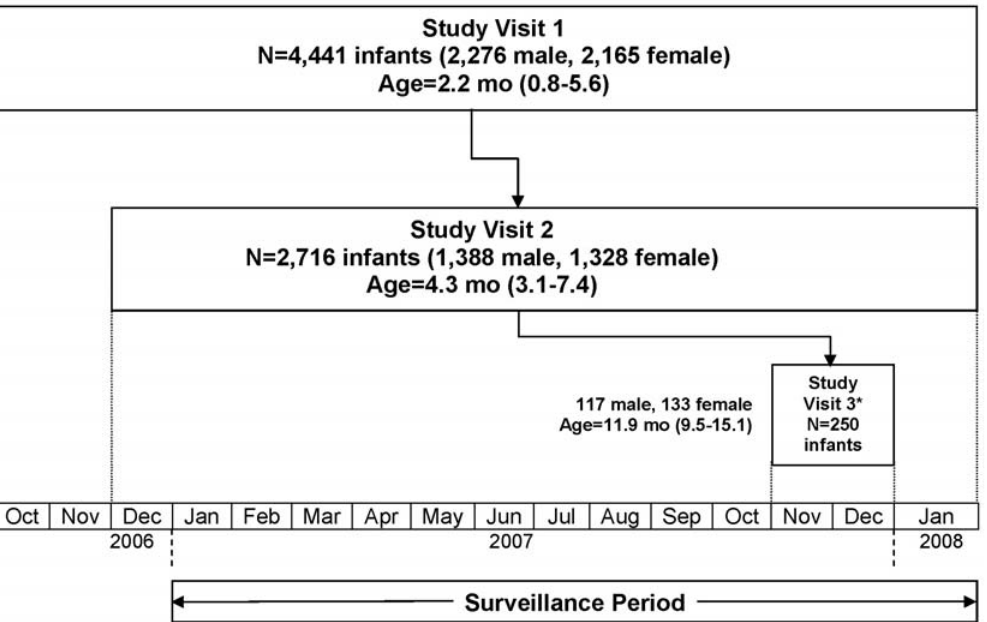
Figure 1. Flowchart of study participation, October 2006–January 2008. The ages at each study visit are presented as the median (range) in months. *, A subset of 250 infants who had completed study visits 1 and 2 were selected for a third study visit in November/December 2007. These infants did not have any previously reported febrile illnesses.